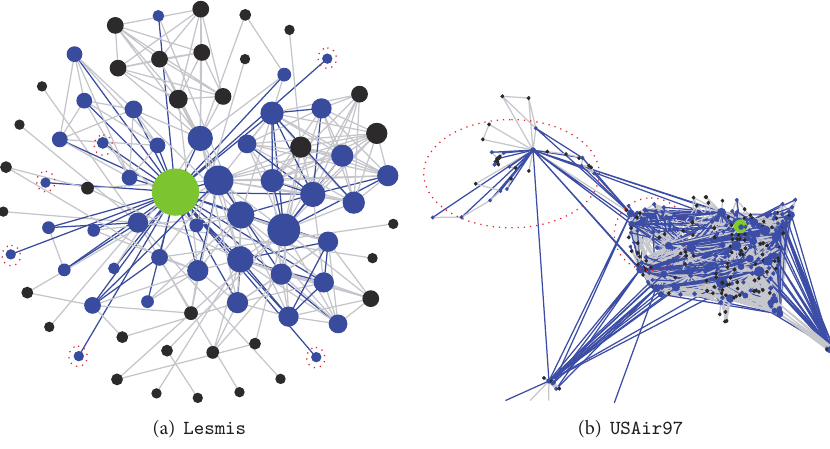
Figure 8: Backbones extracted by BEHwII 𝐻∗